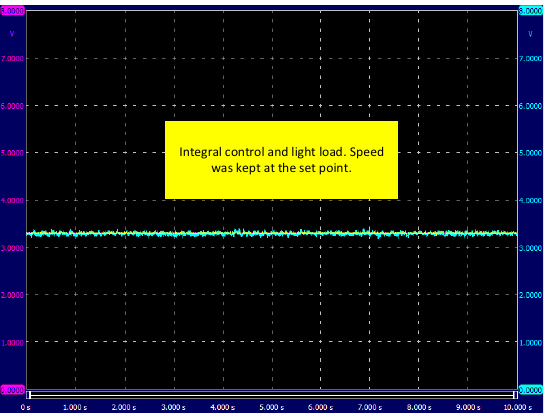
Fig. 6. Tachometer signal obtained in the second experiment with light load